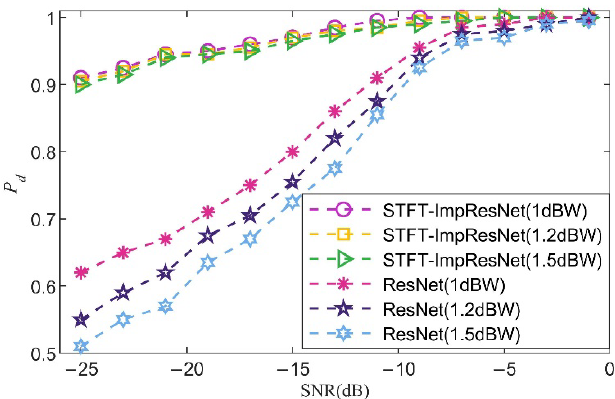
Figure 8. Detection probability curve of different noise powers.